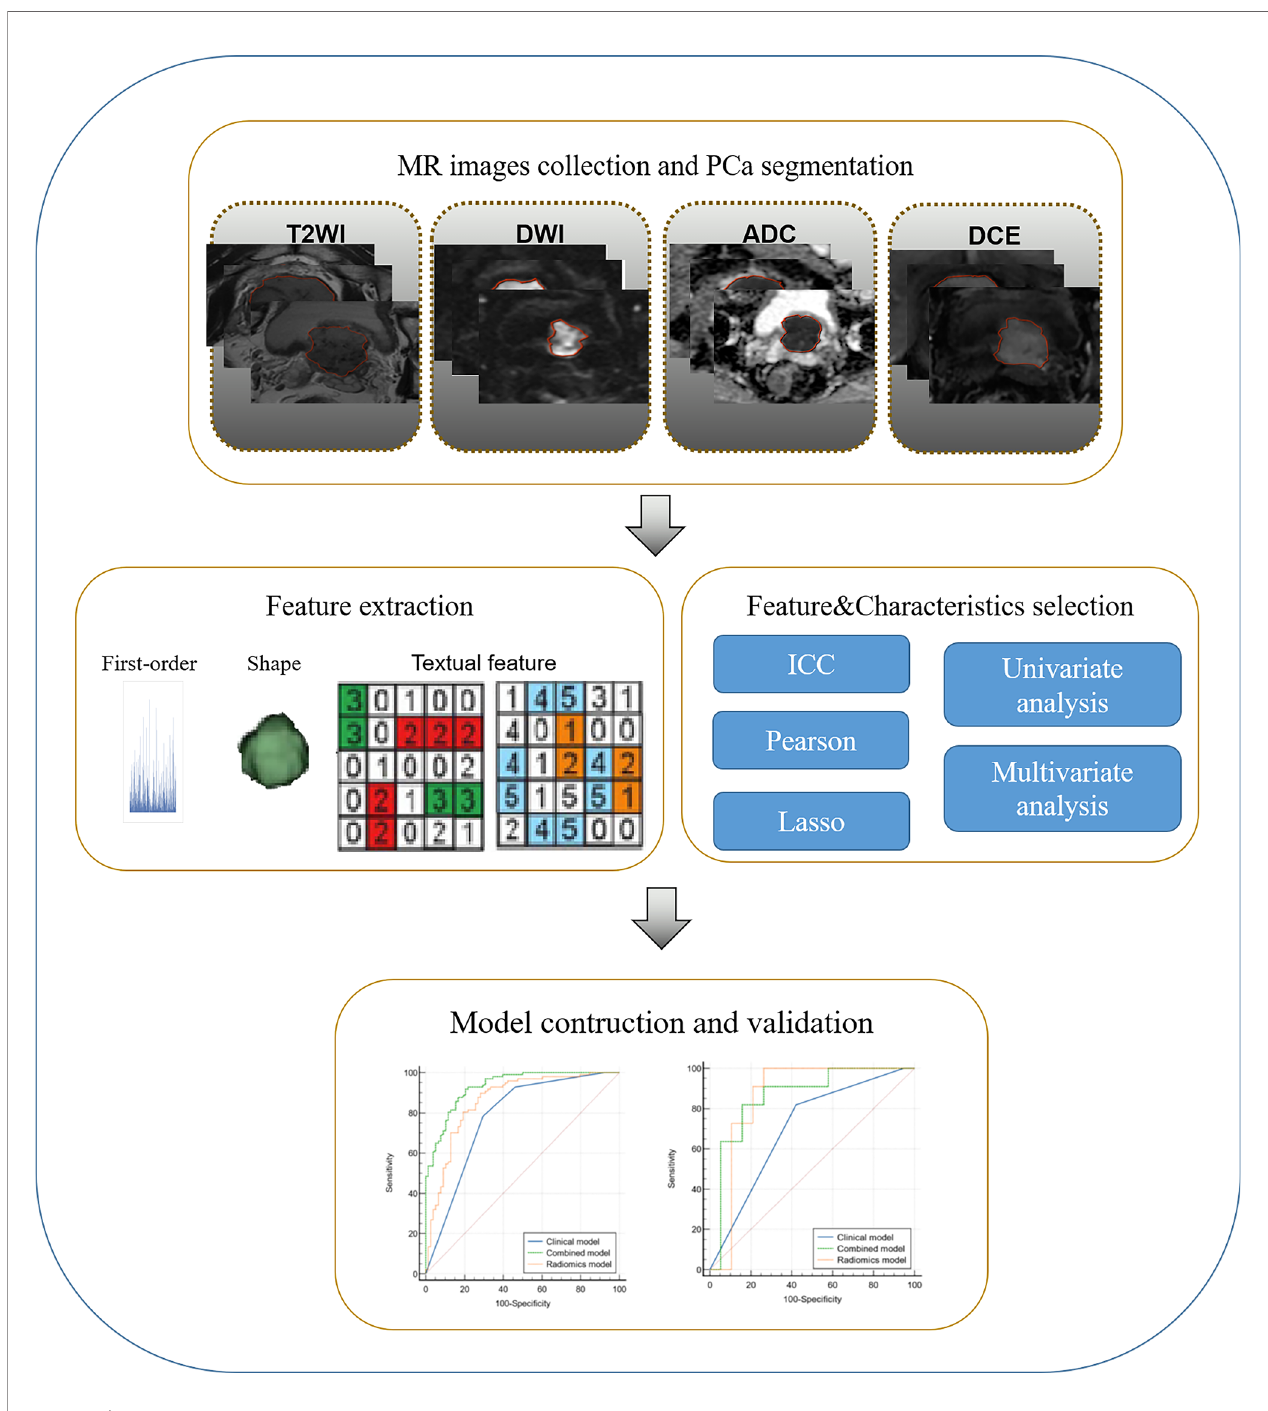
FIGURE 2 | Radiomics work fl